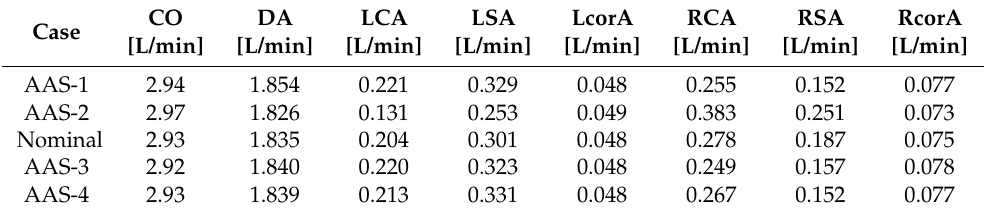
Table 16. Total Systemic Flow Rate [L/min] as a function of D AA and flow rates at each outlet boundary CO, DA, LcorA, RcorA, LCA, RCA, RSA, and RcorA.